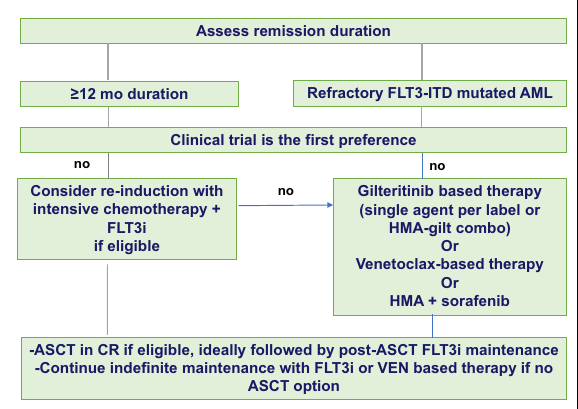
Treatment algorithm of Relapsed or Refractory FLT3 -ITD mutated AML